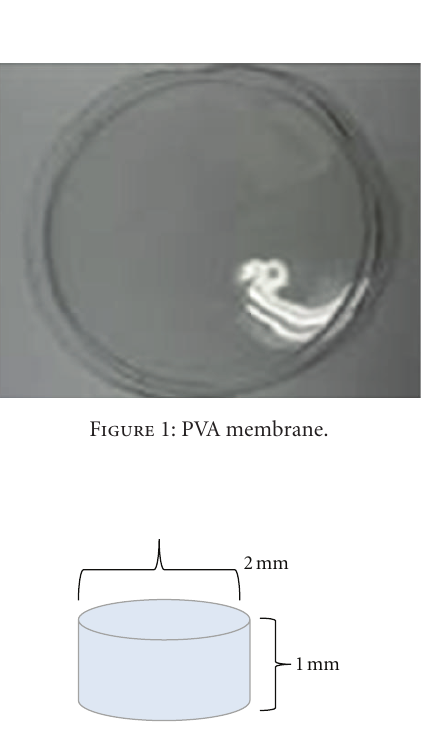
Figure 2: Osteochondral implant